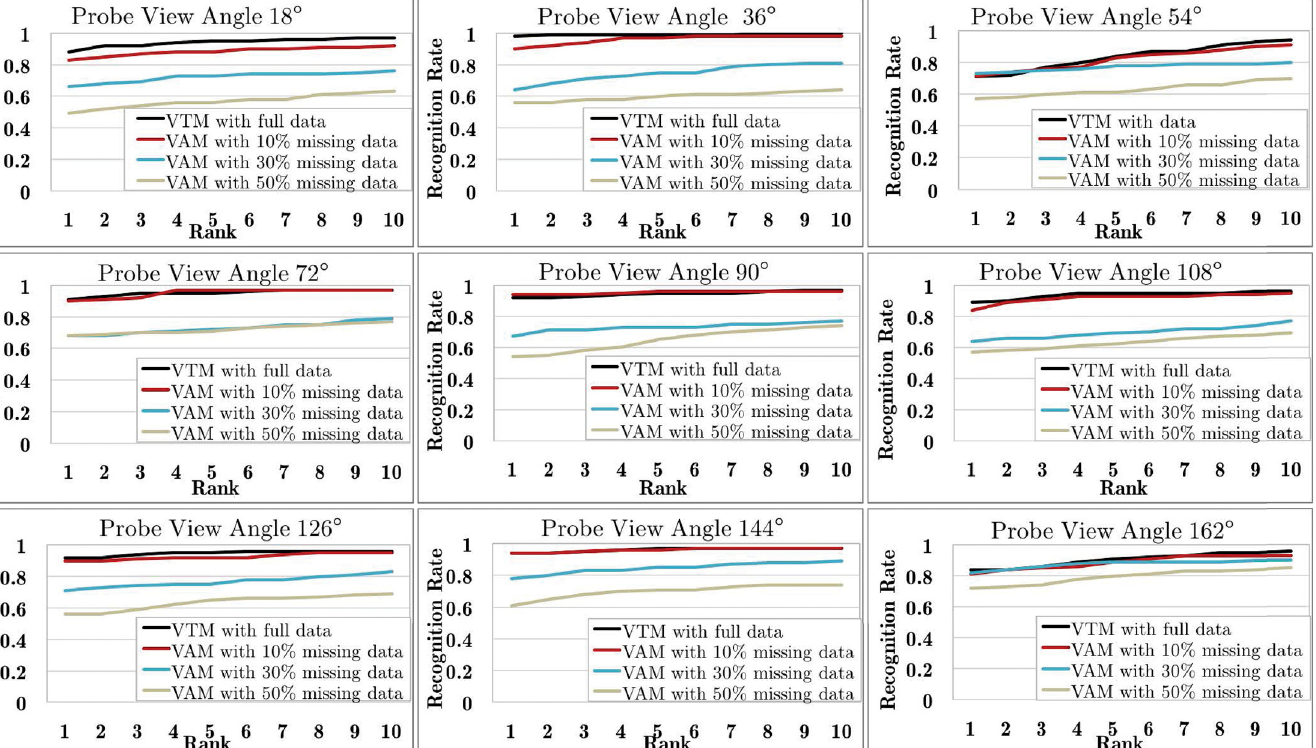
PLOS ONE | https://doi.org/10.1371/journal.pone.0214389 April 16,